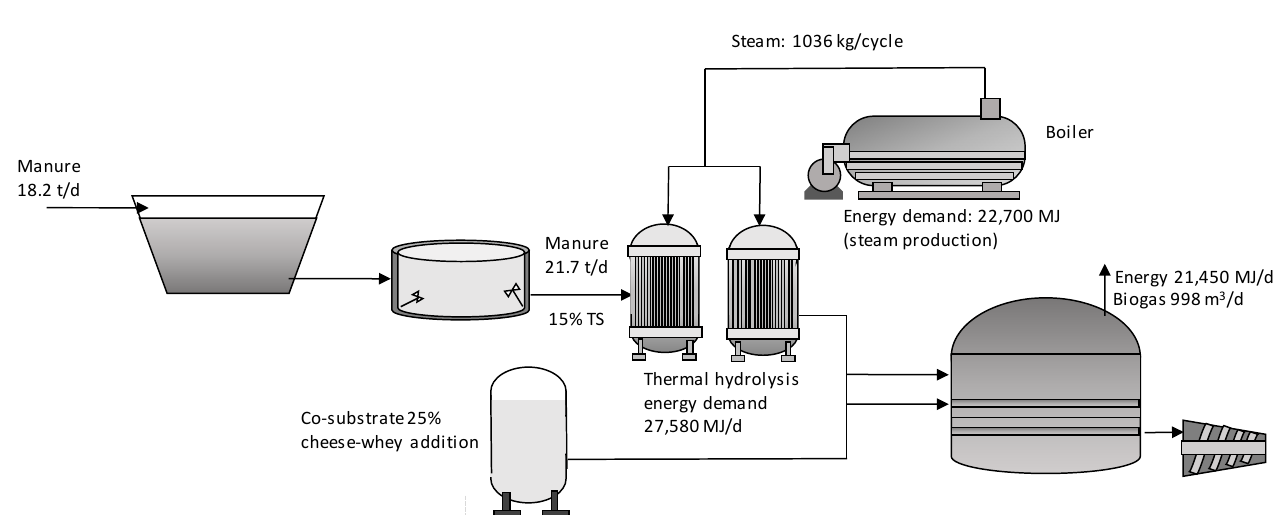
Figure 5. Representation of the main treatment stages in Scenario 3 (thermal hydrolysis and anaerobic digestion of hydrolyzed manure). Cheese whey is used also as co-substrate in this scenario.